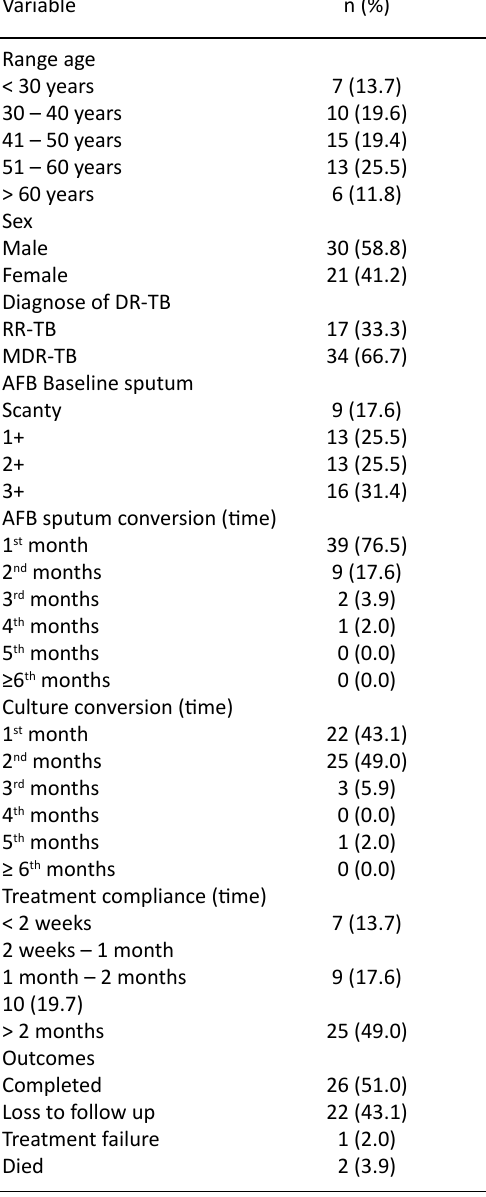
table 2. General demographic and clinical characteristics